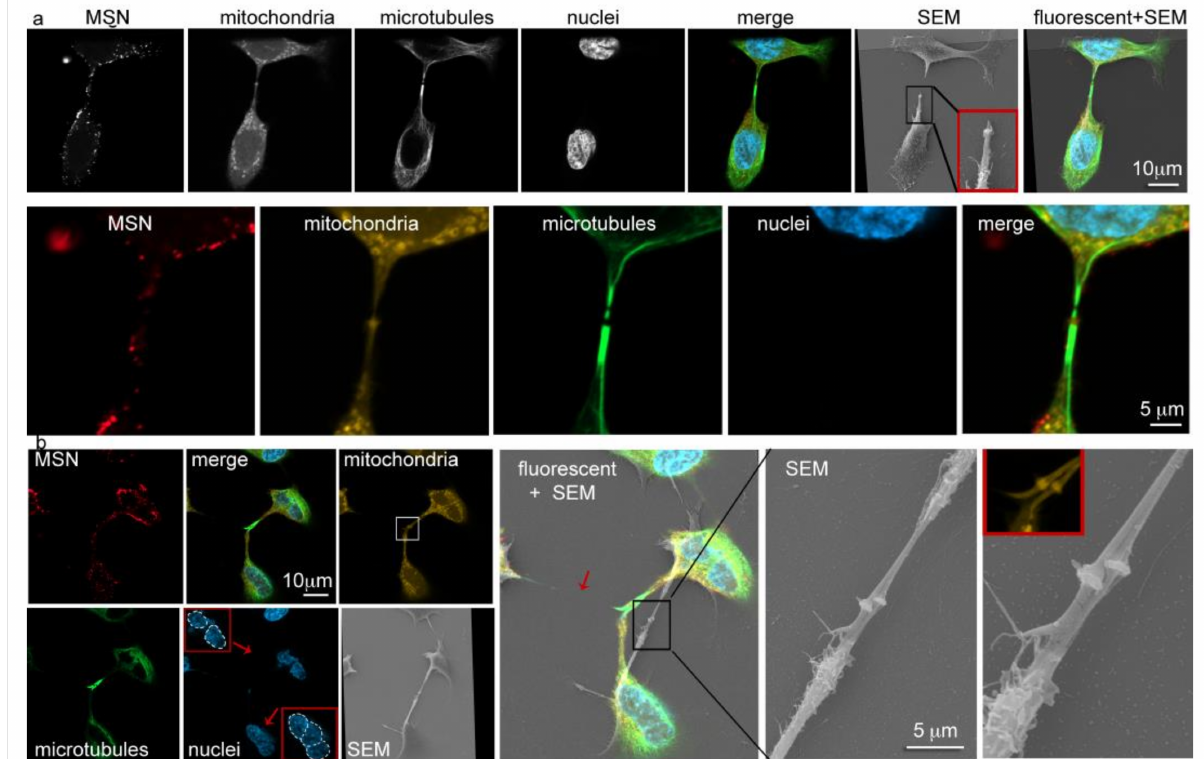
Figure 7. Correlative scanning electron and fluorescent microscopy imaging of a telophase HeLa cell. Merged and single fluorophore confocal and SEM images of two telophase HeLa cells [( a ) division; ( b ) trivision] following 1 h incubation with 10 µ g/mL DyLight 550-conjugated MSN (red). Cells were fixed and labeled with AF488 anti- α -tubulin antibody (microtubules; green), MitoTracker Red (mitochondria; yellow) and DAPI (nuclei; blue; red box insets show individual nuclei in ( b )). Fluorescent and SEM images were acquired using the Zeiss Airy Scan confocal microscope and the Zeiss Sigma SEM, respectively. Shuttle and Find software was used to overlay the images. The arrow (cyan) indicates the SEM procedural break site in the mitotic